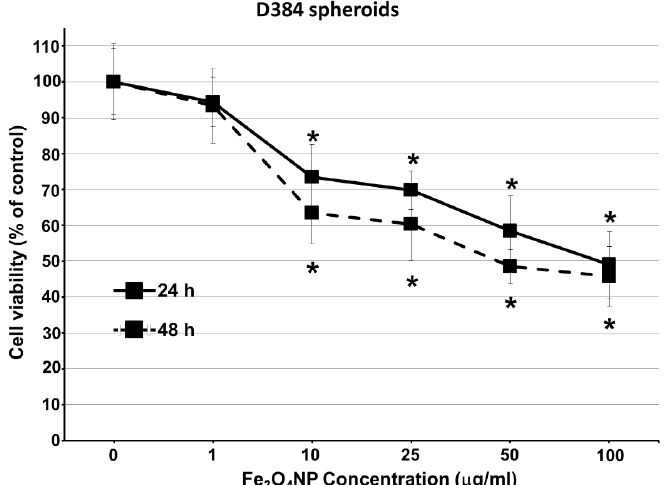
Figure 2. Cell viability evaluation in astrocyte spheroids after short-term exposure to Fe 3 O 4 NPs. Effect on cell viability evaluated by Trypan blue test in D384 spheroids exposed to different concentrations of Fe 3 O 4 NPs (1–100 µ g/mL) after 24 and 48 h. Data are expressed as percentage of viable cells and represent the mean ± S.D. * p < 0.05, statistical analysis by two-way ANOVA followed by Dunnett’s